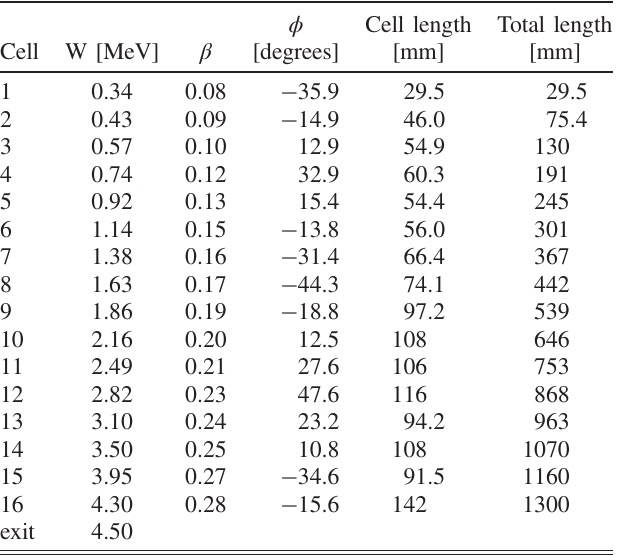
TABLE I. Cell parameters for optimized phase array.